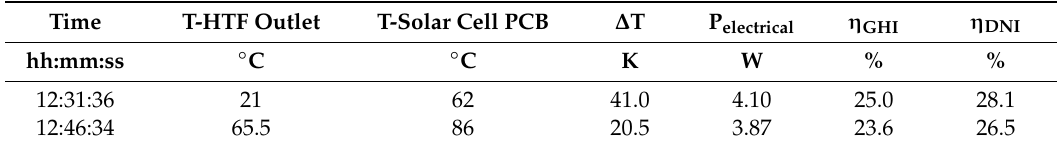
Table 6. Essential results of the measurement. Same e ffi ciency calculations as in previous measurement (see Section